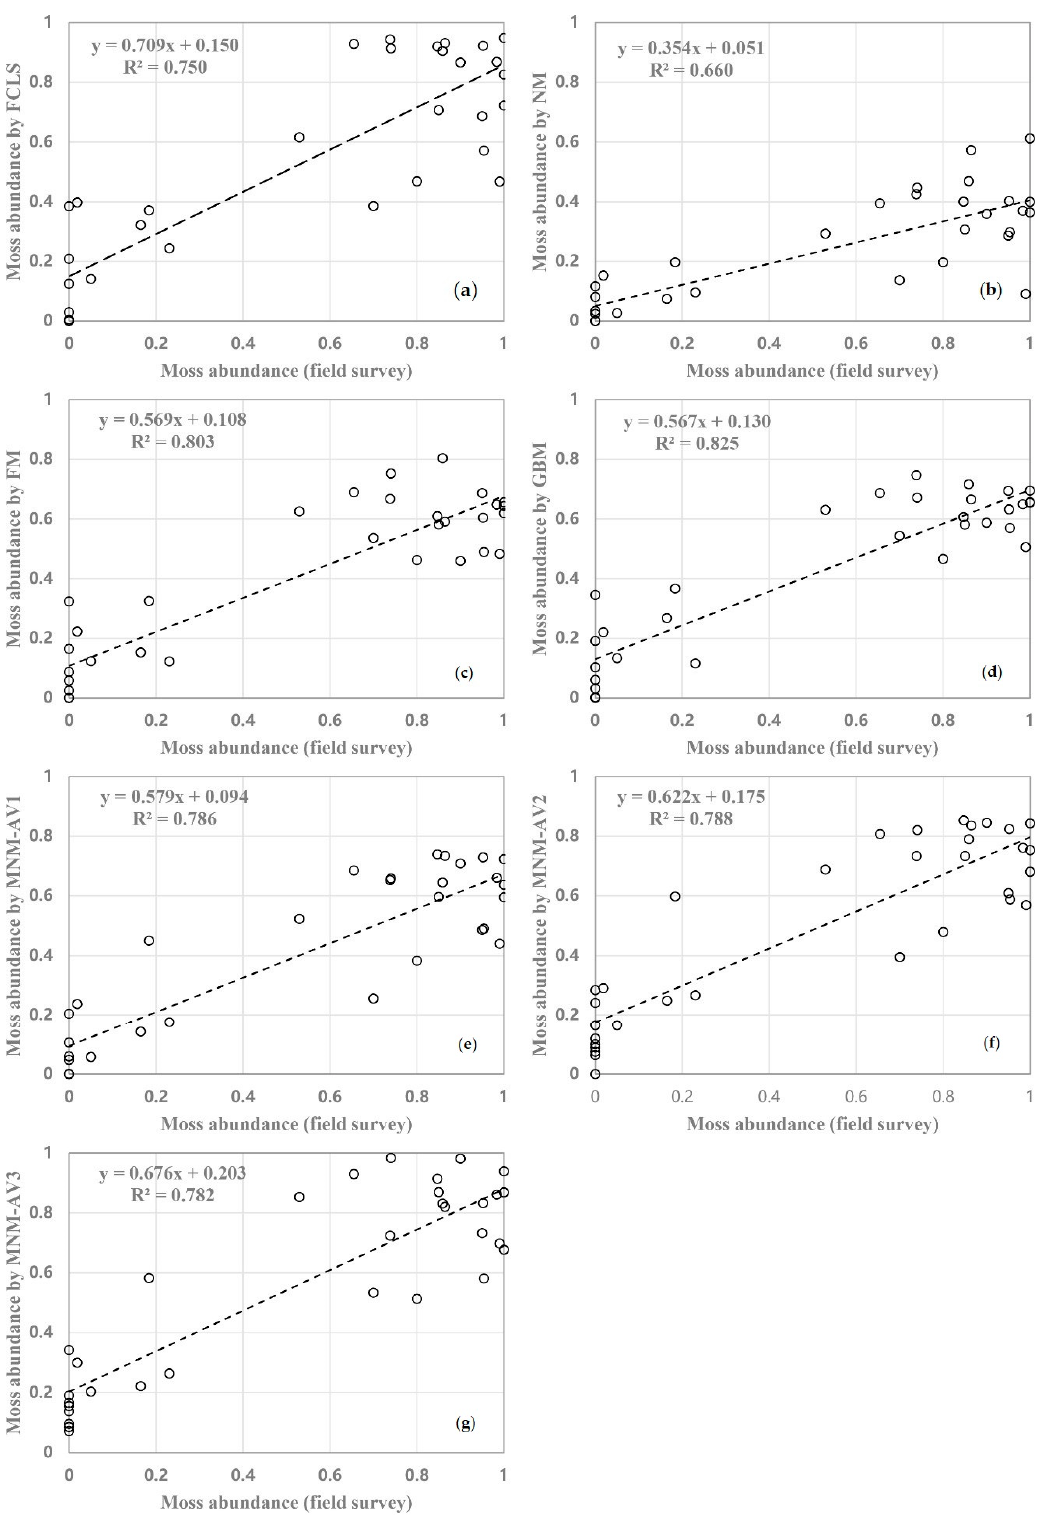
Figure A3. Relationship between moss abundance derived from field surveys and different models estimates ( a ) FCLS; ( b )